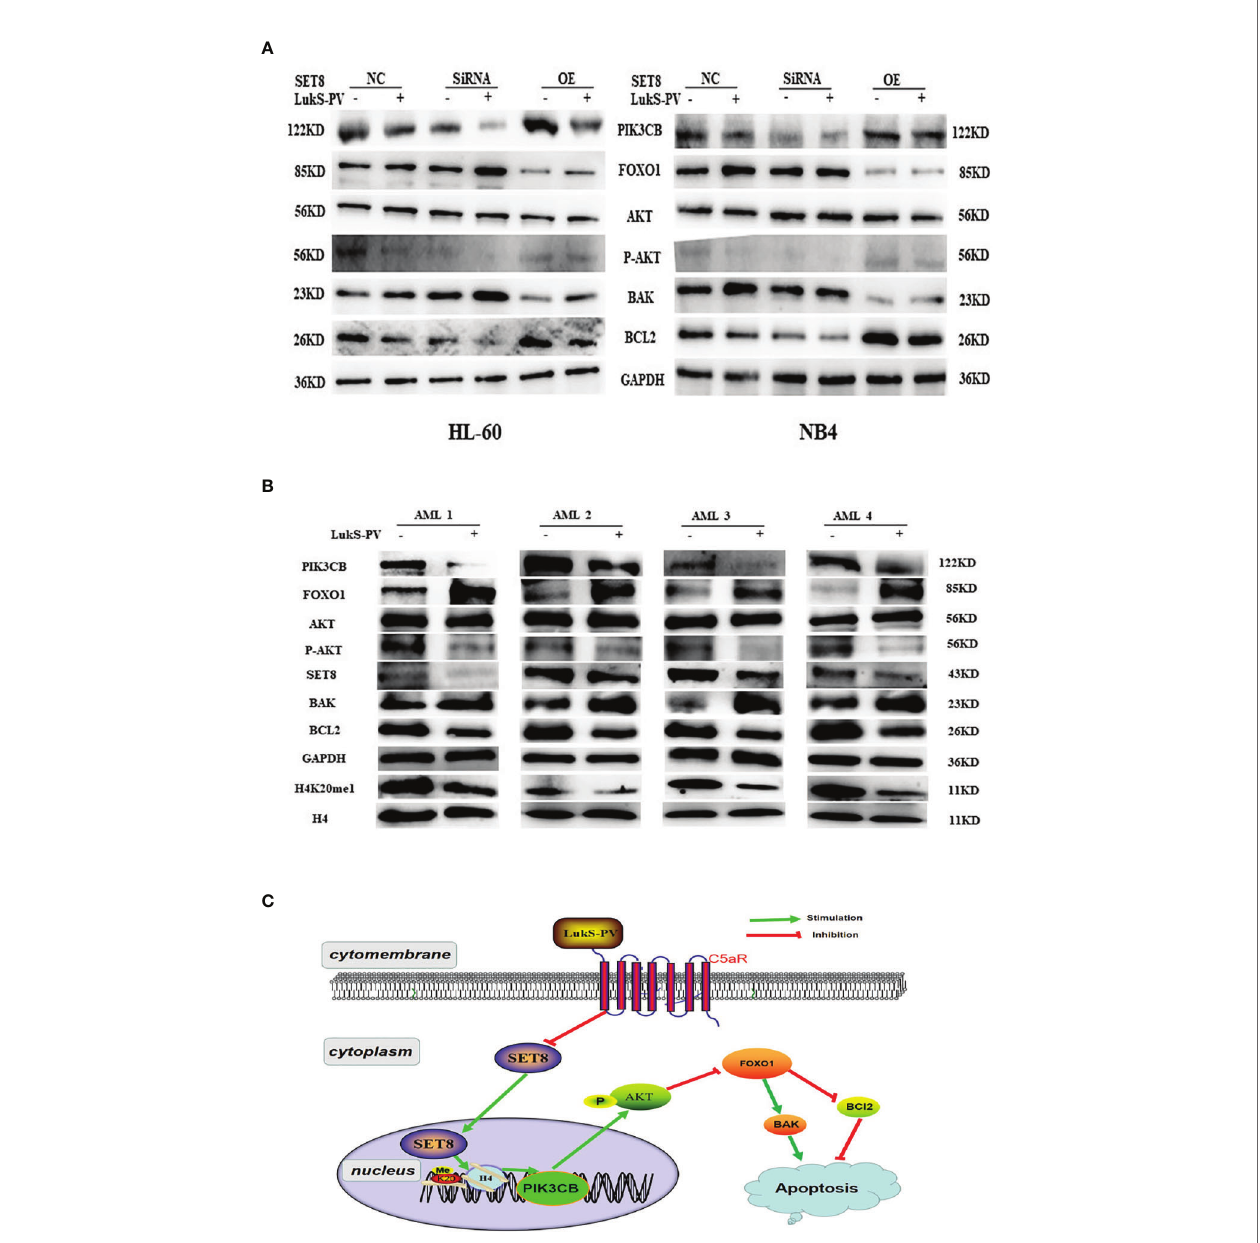
FIGURE 7 | LukS-PV induces apoptosis via the PIK3CB signal pathway by targeting SET8. (A) Levels of PIK3CB, FOXO1, AKT, apoptosis ‐ associated (BAK/BCL2) proteins, and AKT phosphorylation in HL-60 and NB4 cells were assessed through Western blotting. (B) Expression levels of SET8, H4K20me1, PIK3CB, FOXO1, AKT, apoptosis ‐ associated (BAK/BCL2), proteins, and AKT phosphorylation in primary acute myeloid leukemia (AML) blasts were assessed through Western blotting. (C) Proposed mechanism of action of LukS-PV in acute myeloid leukemia cells. SET8-OE, SET8 overexpression; SET8-NC, SET8 negative control; SET8- SiRNA, SET8 small interfering